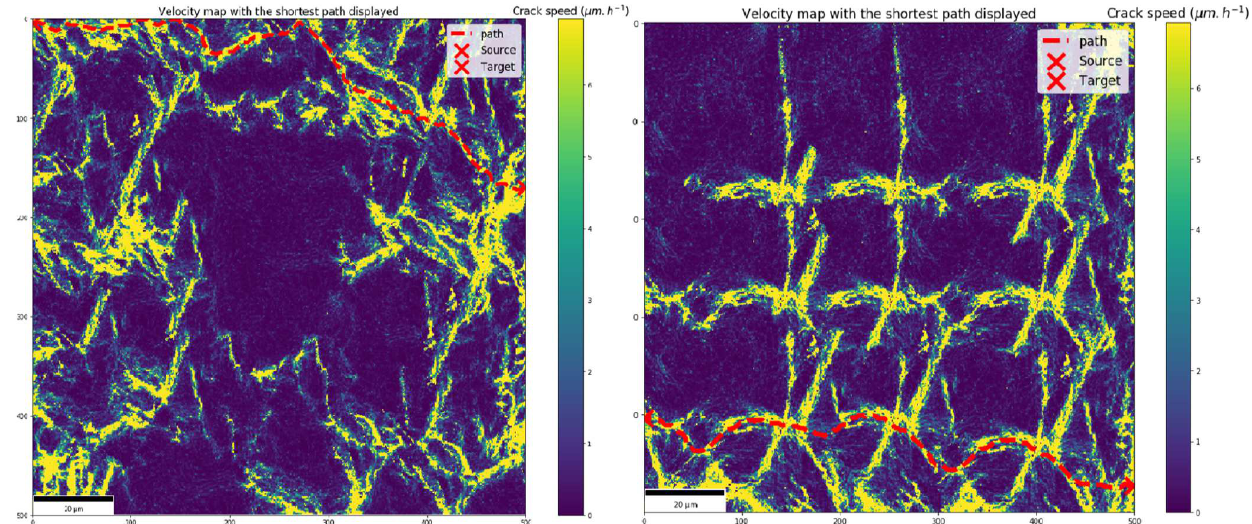
Fig. 15. Shortest paths (red dots) displayed on top of the velocity maps for two realizations of the CCSIM issued from the map at (cid:15) = 12% - left: T = 60 , OL = 20 , right: T = 230 , OL = 78